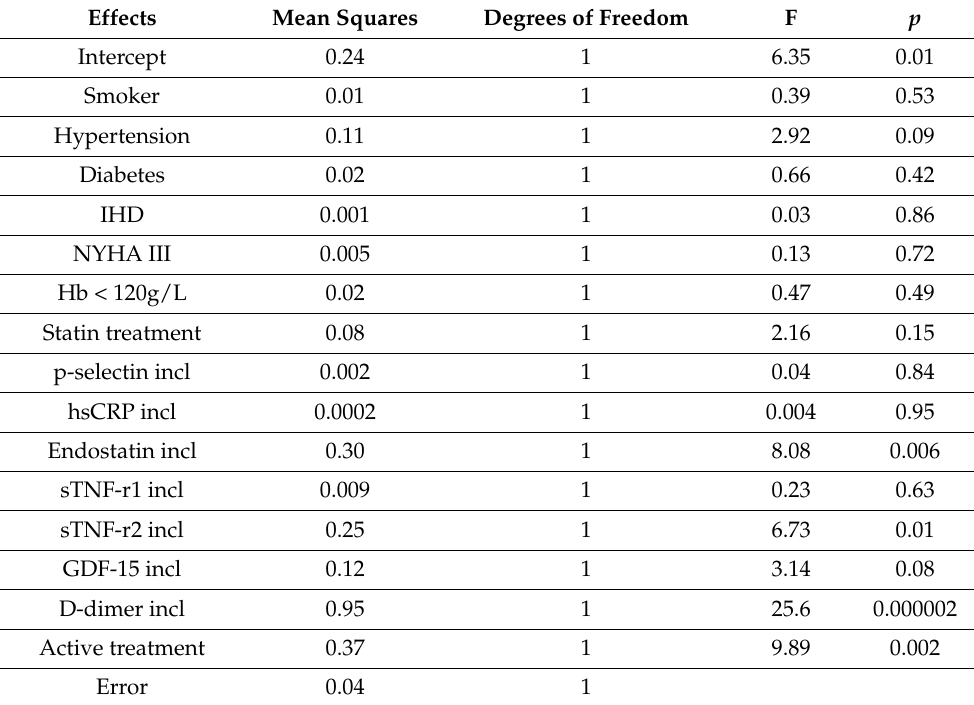
Table 2. Analysis of covariance using D-dimer after 48 months as dependent